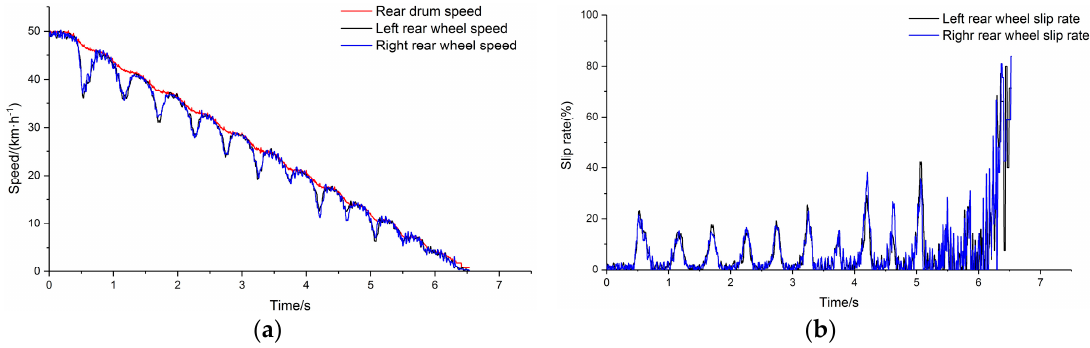
Figure 19. ( a ) Comparison of main drum speed and wheel speed; ( b ) slip rate.